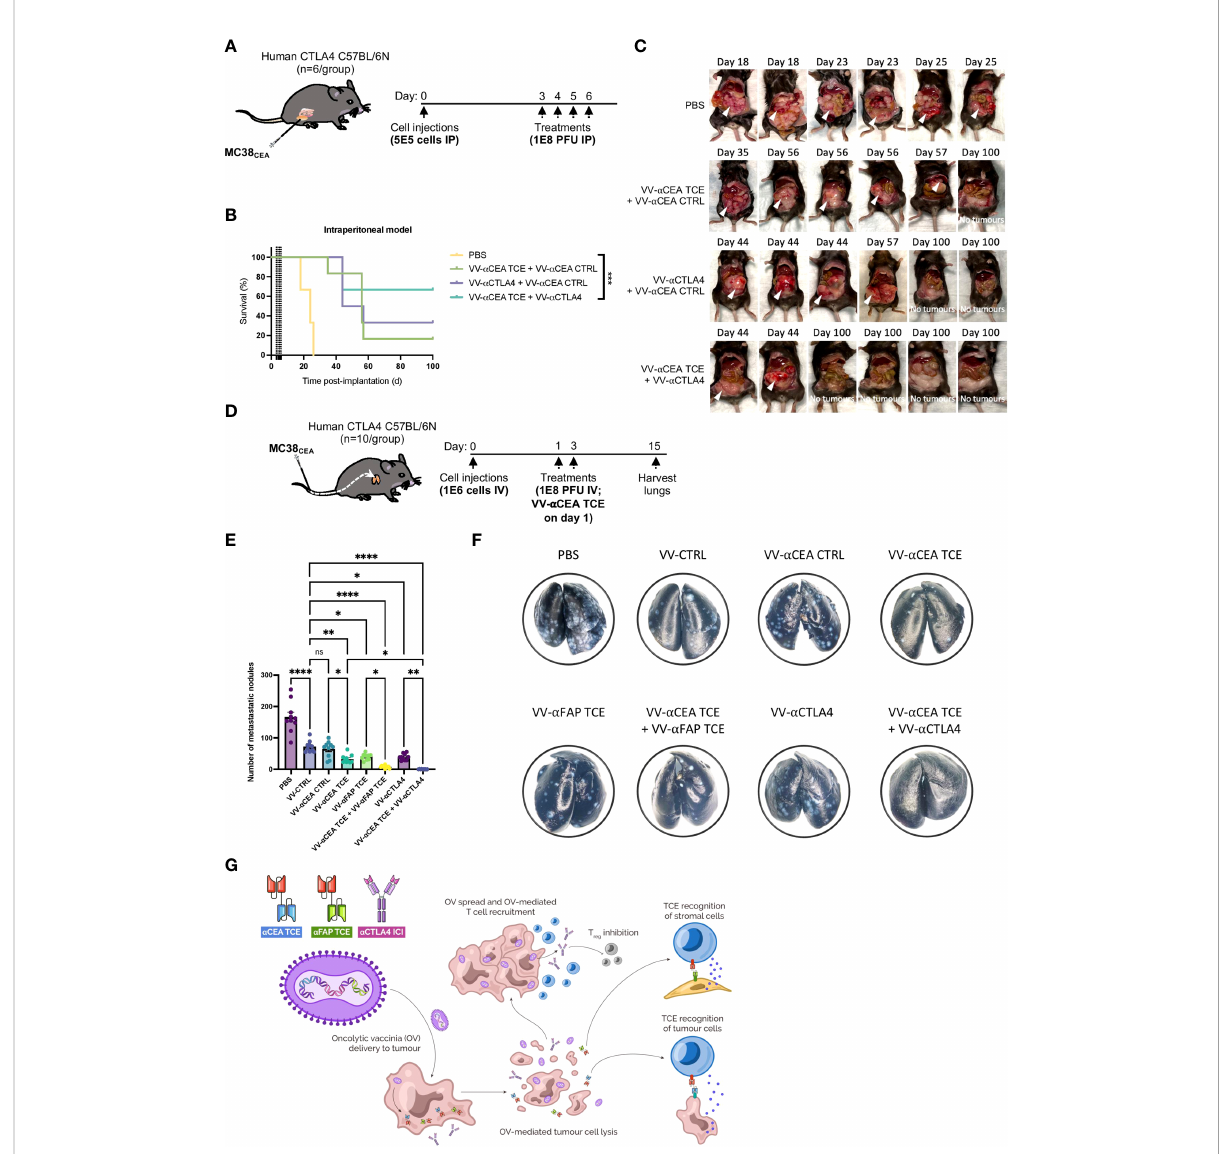
FIGURE 6 Combination viro-immunotherapy for aggressive CRC peritoneal carcinomatosis and lung metastasis models. (A) C57BL/6N mice that express human CTLA4 instead of murine CTLA4 on T cells and bear intraperitoneal MC38 CEA tumours, were injected intraperitoneally with 4 doses of viruses at 1E8 pfu, or PBS as control, at days 3, 4, 5 and 6. (B) Antitumour ef fi cacies of the following combinations were assessed compared to PBS alone: VV- a CEA TCE ( a CEA:mCD3) on days 3 and 5, in combination with VV- a CEA CTRL ( a CEA:hCD3) on days 4 and 6; VV encoding a CTLA4 (which recognizes human CTLA4; VV- a CTLA4) on days 3 and 5, in combination with VV- a CEA CTRL ( a CEA:hCD3) on days 4 and 6; VV- a CEA TCE ( a CEA:mCD3) on days 3 and 5, in combination with VV- a CTLA4 on days 4 and 6. Mice bearing MC38 CEA tumours treated with viruses showed signi fi cantly prolonged survival in this aggressive peritoneal carcinomatosis model, and 66% of mice were cured after the combination treatment of VV- a CEA TCE and VV- a CTLA4. (C) Treated mice were dissected upon endpoint or at day 100 for cured mice to con fi rm no tumours. (D) Following intravenous injection of MC38 CEA cells (1E6) in human CTLA4 C57BL/6N mice, we administered 2 doses of viruses at 1E8 pfu, or PBS as control, and harvested the lungs at day 15 for staining. (E) In the CRC metastasis model, VV- a CEA TCE, VV- a FAP TCE, and VV- a CTLA4 monotherapies signi fi cantly reduced the number of metastatic nodules in the lungs compared to VV-CTRL or VV- a CEA CTRL, and especially PBS control. Combinations of VV- a CEA TCE with either VV- a FAP TCE or VV- a CTLA4 demonstrated synergy in further decreasing the number of lung metastases. Some of the lungs of the mice treated with VV- a CEA TCE and VV- a CTLA4 were completely cleared of metastases. Results show number of metastatic nodules ± SEM; One-way ANOVA. (F) Images of metastases (white spots) in lungs harvested from mice at day15, after being in fl ated with india ink and fi xed. (G) Schematic illustrating the combination of viro-immunotherapies targeting CEA on cancer cells and FAP on stromal cell populations (CAFs) by TCE, and T regs through immune checkpoint inhibitor (ICI) a CTLA4 to boost T cell responses for the treatment of